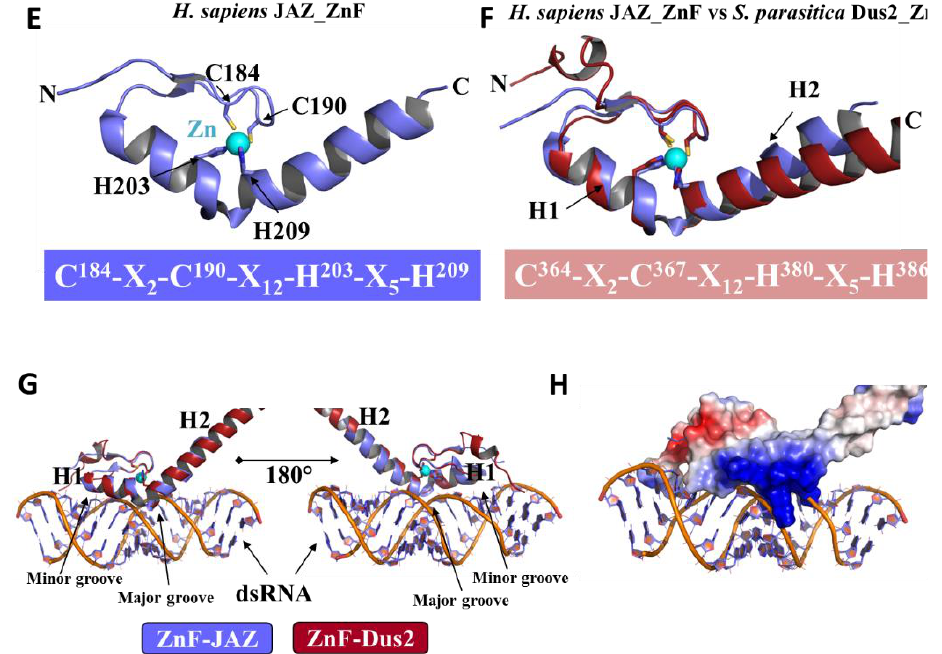
Figure 6. The Zinc finger domain in Dus2. ( A ) Structural 3D model of A. candida Dus2. The canonical domains are in gray while the c- α H and the ZnFD are in green and red, respectively. ( B ) Structural 3D model of S. parasitica Dus2. ( C , D ) Zoom on the zinc finger motifs of A. candida and S. parasitica Dus2, respectively. The signature of the motif is indicated in the red box. ( E ) Solution NMR structure of a ZnFD of human JAZ protein (PDB: 2MKN). The zinc atom is represented as a ball colored in cyan. The ZnF motif for this domain is indicated below the structure. ( F ) Structural superposition of 2MKD (colored in purple) with the ZnFD of S. parasitica Dus2 (in red). The ZnF motif of S. parasitica Dus2 is shown below the figure of the structural alignment. ( G ) Structural superposition of 2MKN (PDB code for the structure of JAZ ZnFD in complex with a dsRNA with the ZnFD of S. parasitica Dus2 (in red). Two different views that differ by a rotation of 180 ◦ around the z-axis are shown. ( H ) Model of the S. parastica Dus2/dsRNA complex. The ZnFD is represented in the electrostatic surface mode.